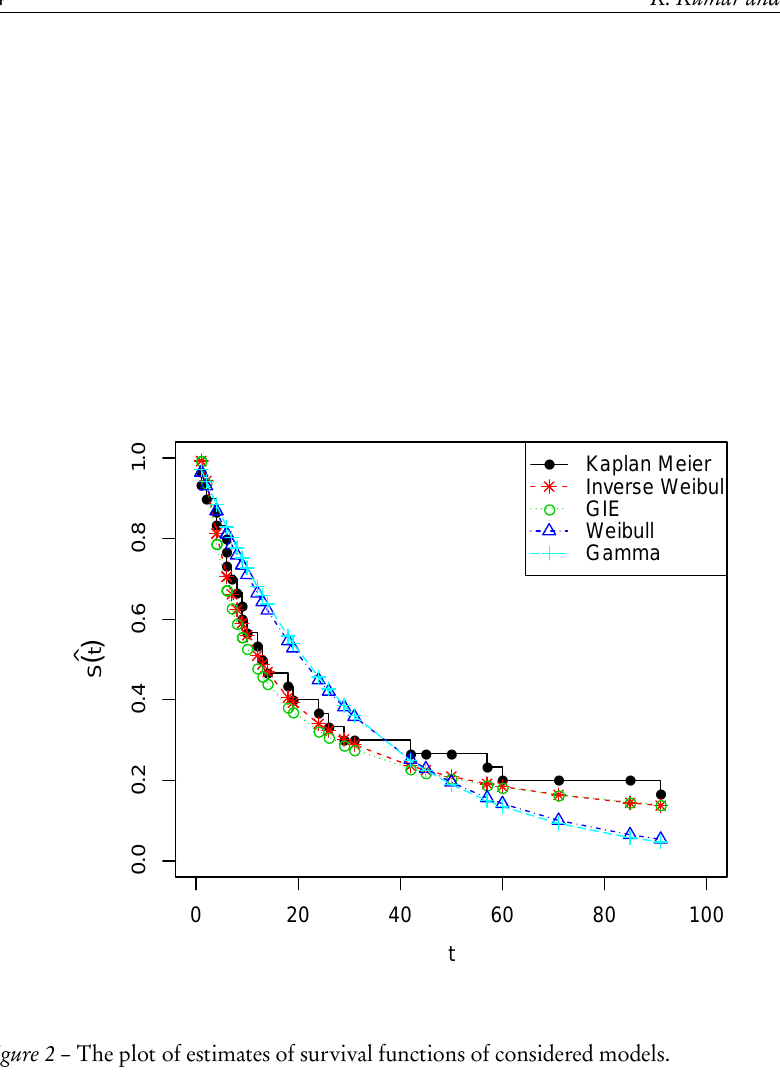
Figure 2 – The plot of estimates of survival functions of considered